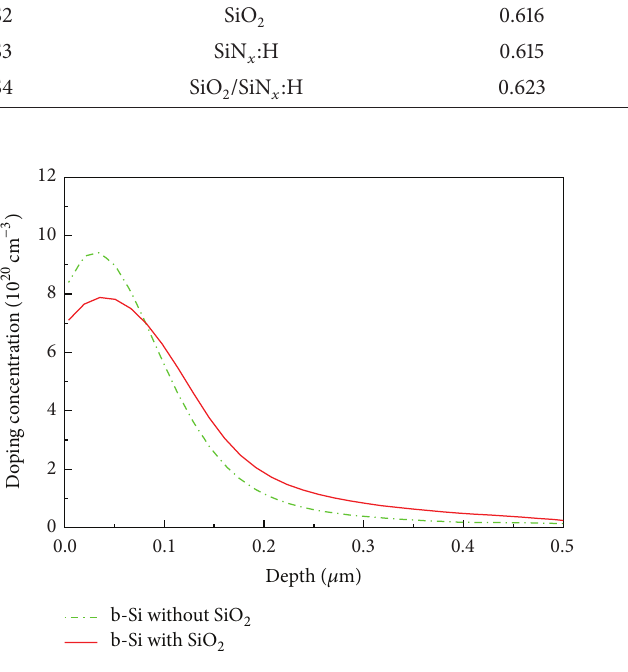
Figure 4: Doping profile for the diffused emitter of b-Si solar cells with and without SiO 2 passivation film by ECV.